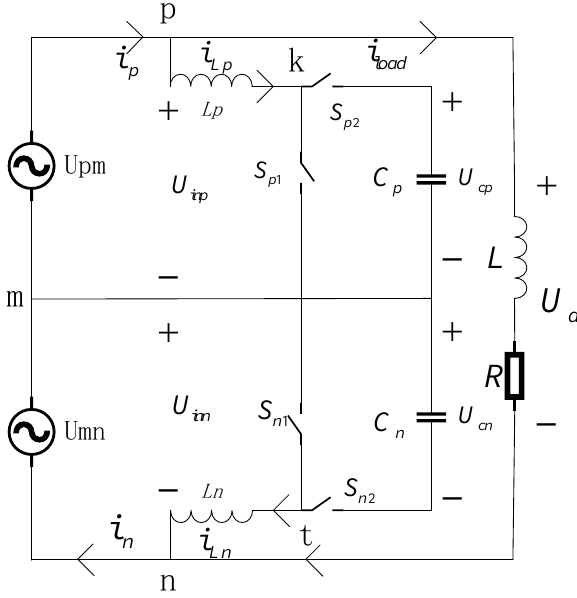
Figure 8. Equivalent circuit diagram of DC-side